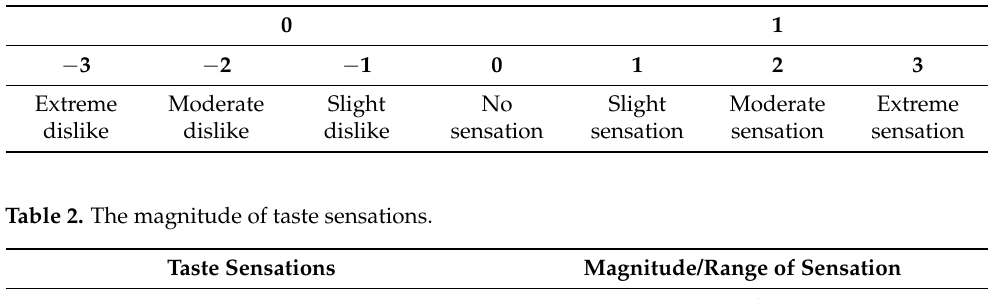
Table 1. Taste sensations scale.